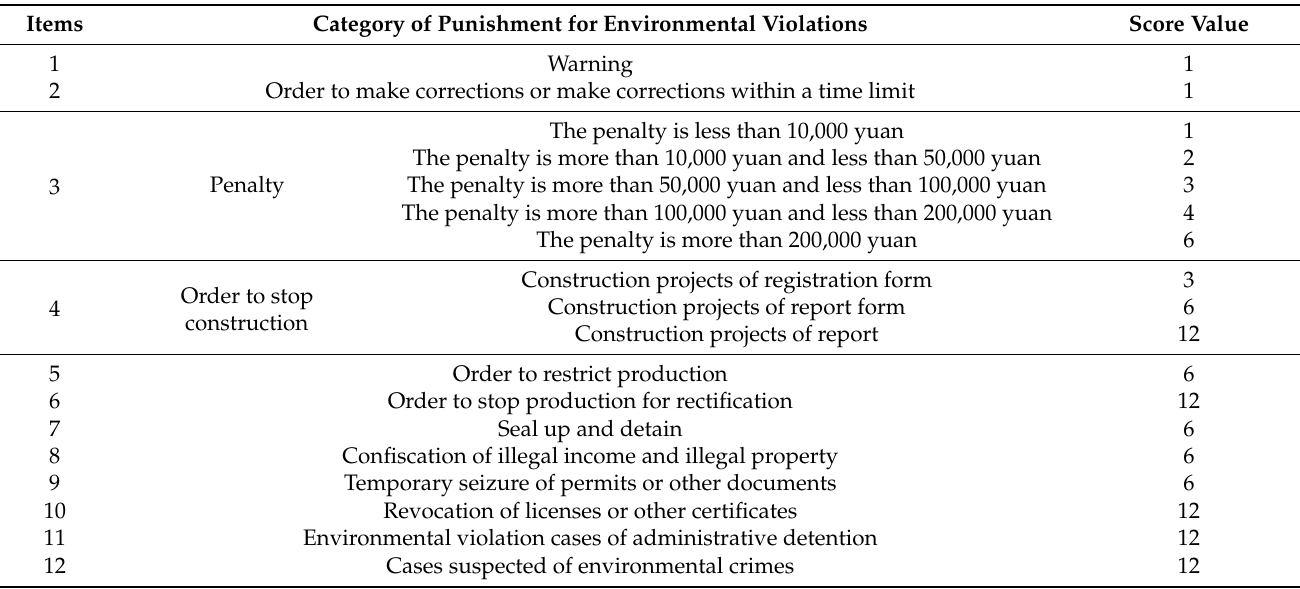
Table 1. Assessment system of firms’ environmental violation